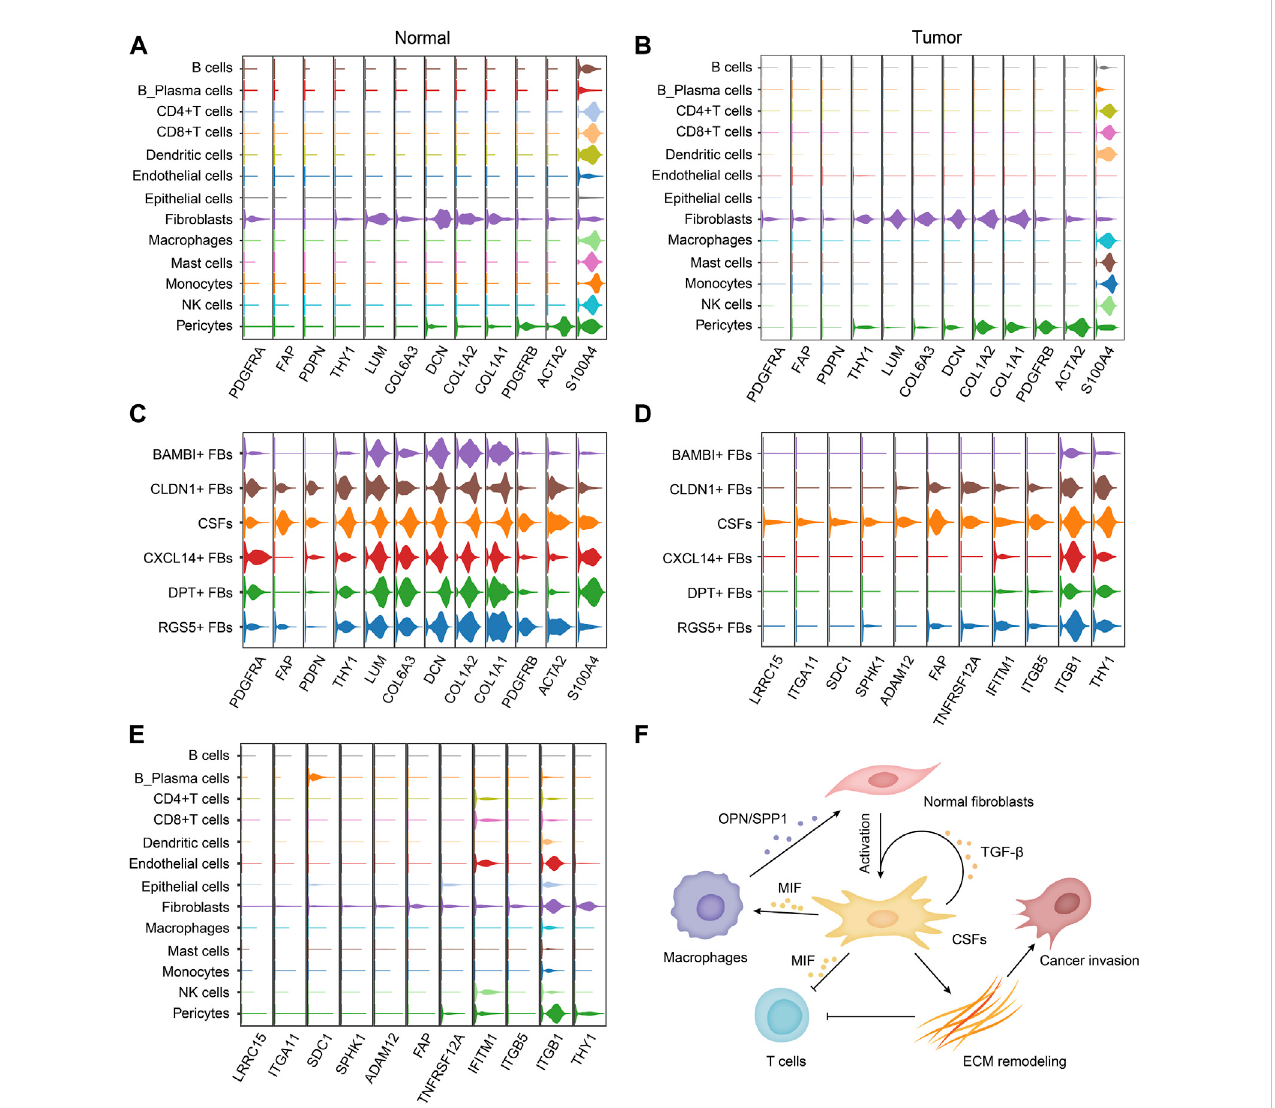
FIGURE 7 CSFs speci fi cally express membrane proteins LRRC15, ITGA11, SPHK1 and FAP. (A, B) , Violin plots to show the expression levels of classical fi broblast markers in different cell types of normal tissues (A) and tumor tissues (B) . (C) , Violin plots to show the expression levels of classical fi broblast markers in different fi broblastclusters. (D,E) ,ViolinplotstoshowthehighlyexpressedsurfacemoleculesofCSFsindifferent fi broblastclusters (D) anddifferentcelltypes (E) . (F) , Schematic illustration of the proposed mechanism how CSFs promote tumor